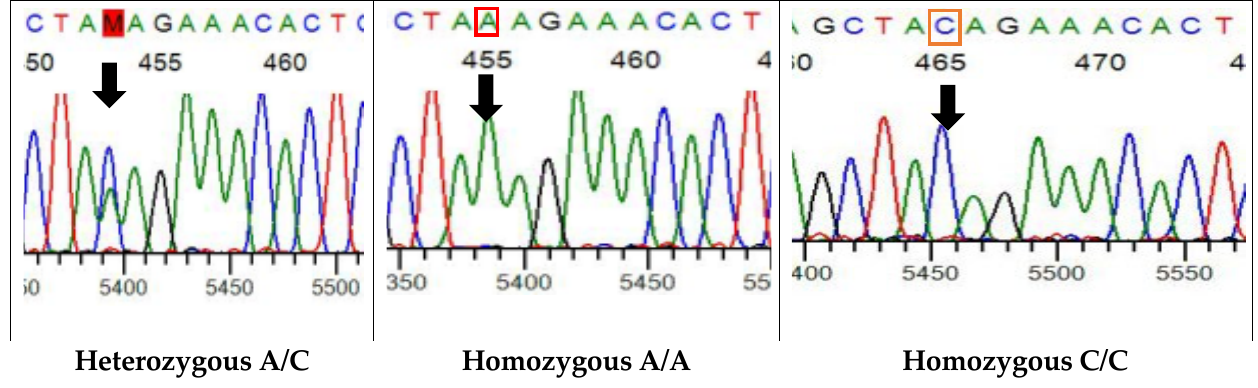
Figure 5. ( A , B ) Linear regression between mother and father TL among genders. No association was found between girls and boys with both parents.